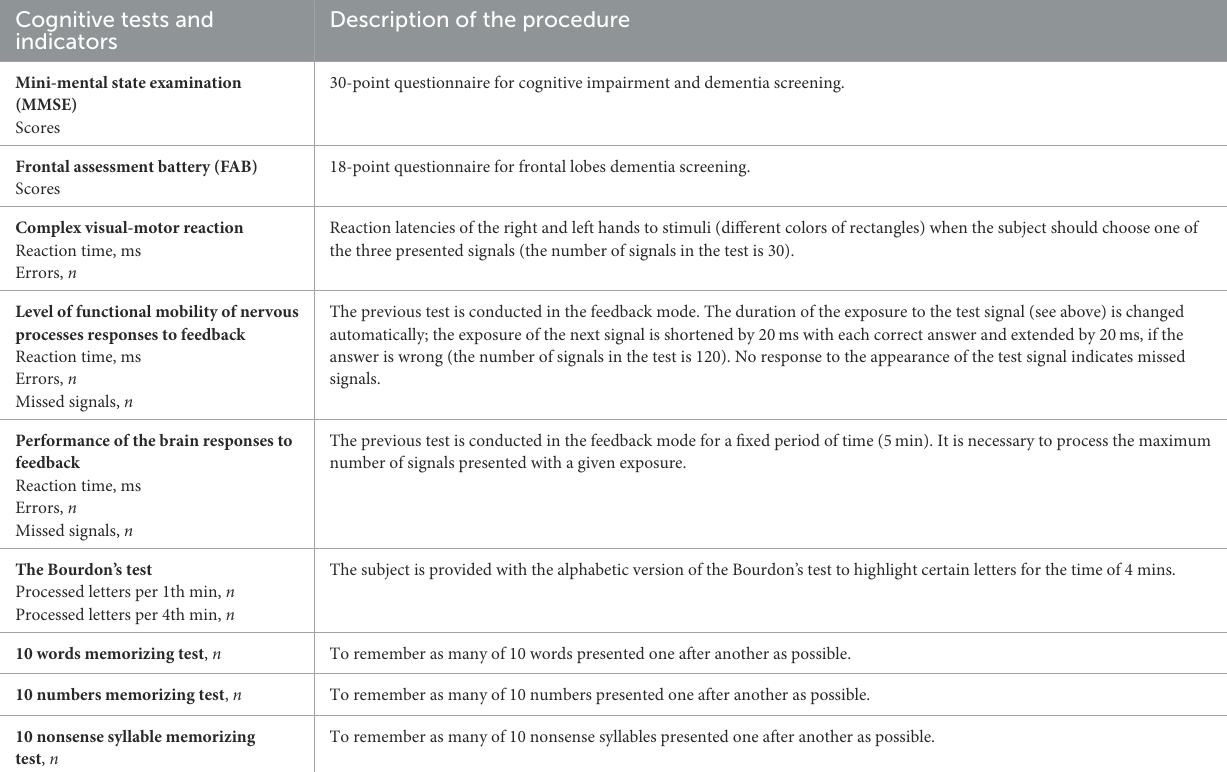
TABLE 2 Cognitive test battery for assessing cognitive function in cardiac surgery patients. Cognitive tests and